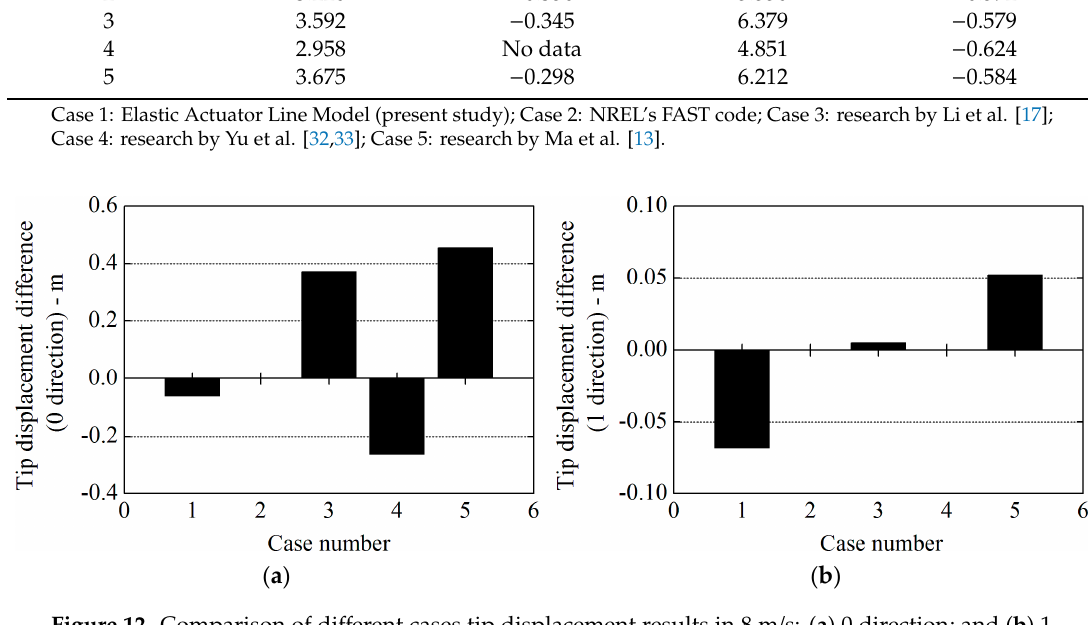
Figure 12. Comparison of different cases tip displacement results in 8 m/s: ( a ) 0 direction; and ( b ) 1 direction Case 1: Elastic Actuator Line Model (present study); Case 2: NREL’s FAST code; Case 3: